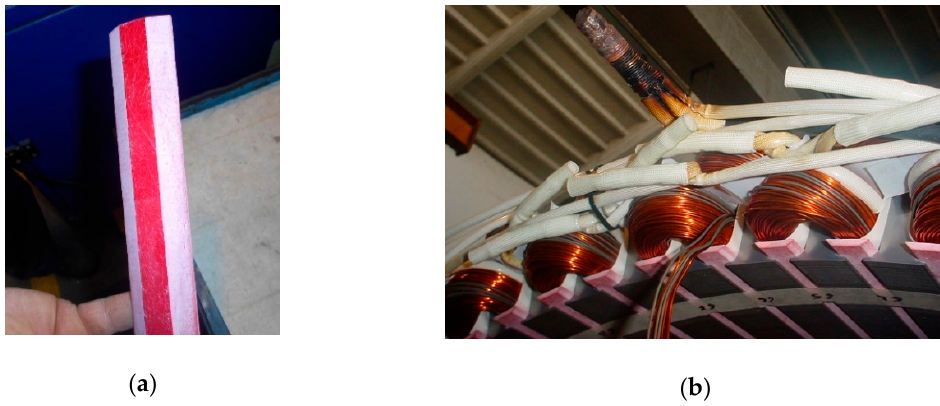
Figure 1. Typical wedges for FSCW machines: ( a ) a single wedge; ( b ) some wedges inserted in the stator slots.